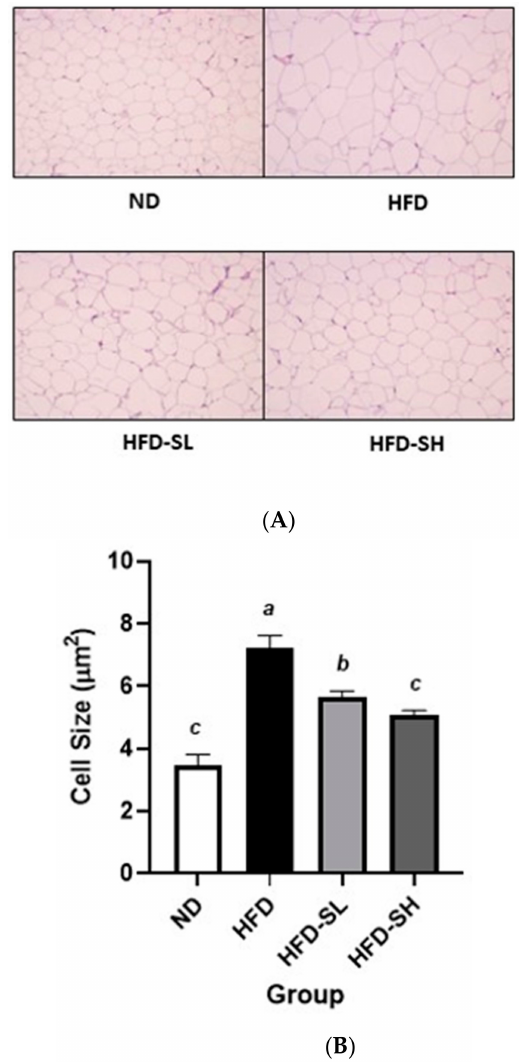
Figure 5. Histological analysis of epididymal adipose tissue (EAT). Rats were fed the normal diet or high-fat diet with / without Spergularia marina Griseb powder supplementation for 4 weeks. EAT was stained with H&E. Magnification, 100 × . The surface area of EAT was measured using the Image J program. ND, Normal diet; HFD, High-fat diet; HFD-SL, High-fat diet + 3% of Spergularia marina Griseb; HFD-SH, High-fat diet + 5% of Spergularia marina Griseb. ( A ) Representative figures from each group. ( B ) The quantification of A. Values are means ± SDs, n = 8. Data were analyzed by one-way ANOVA using Kruskal–Wallis analysis followed by Tukey’s post hoc test. Means labeled without a common letter di ff er, p <